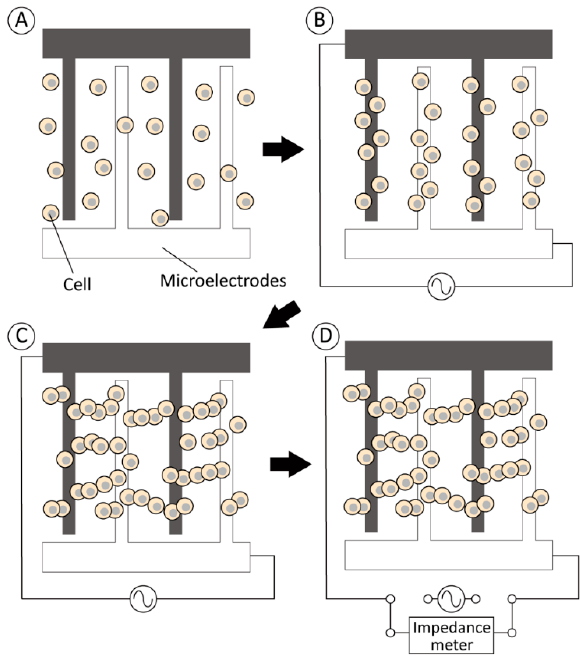
Figure 1. Experimental approach for improving the measurement sensitivity of cell electrical impedance by dielectrophoretic cell accumulation. Dispersed cells on opposing comb-shaped elec- trodes ( A ) were trapped on the electrodes by positive DEP forces ( B ) to form pearl-chain-like cell clusters ( C ). Finally, the electrical circuit was disconnected from the AC voltage source and ( D ) the cell impedance was measured by an impedance